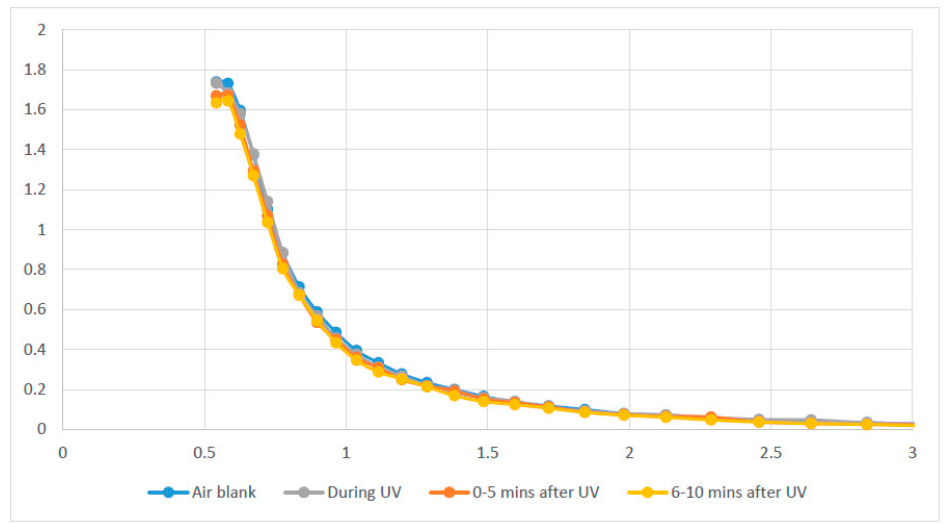
Figure 7. Particulate size distribution (particulate counts per cm 3 versus particle diameter in µm) in a bathroom with an above-door automated UV system, before (air blank), during and after an automated 5 mins UV disinfection cycle. Most points are collinear and superimposed.